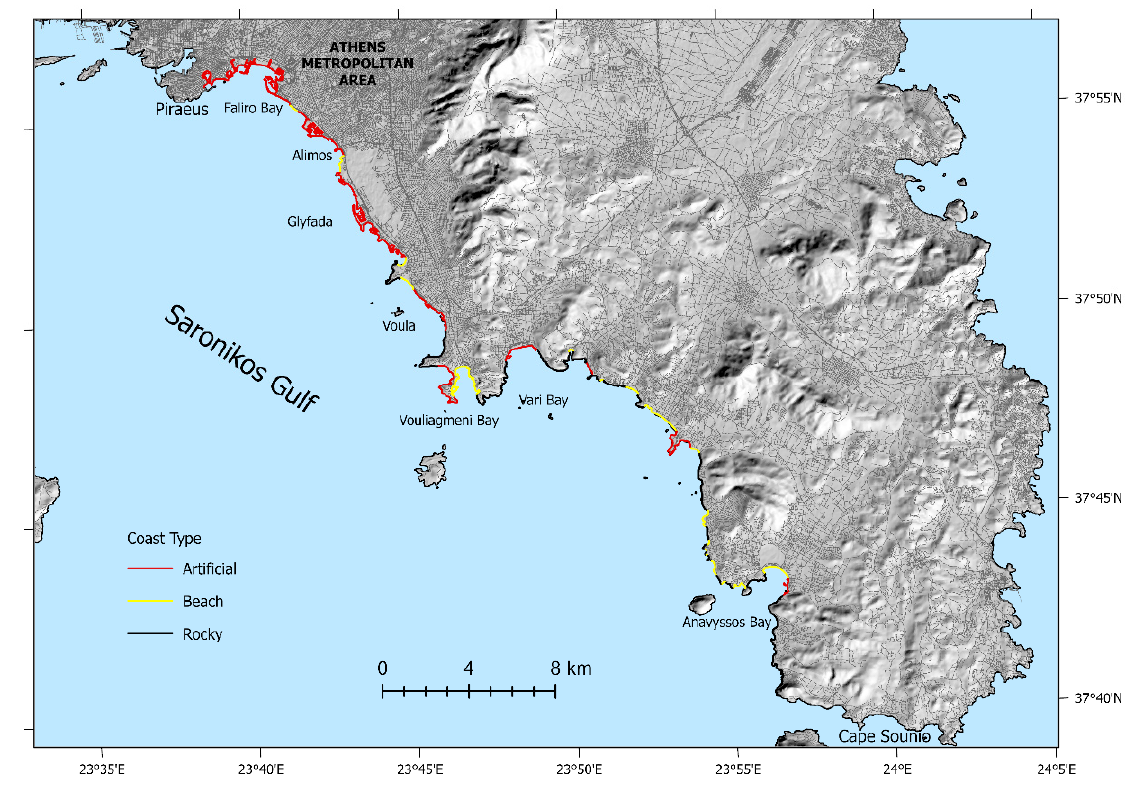
Figure 3. Classification of the coastline based on 2021 imagery and fieldwork. The north part of the study area is characterized as mainly artificial. Table 1. The type of coasts, their length and percentage.